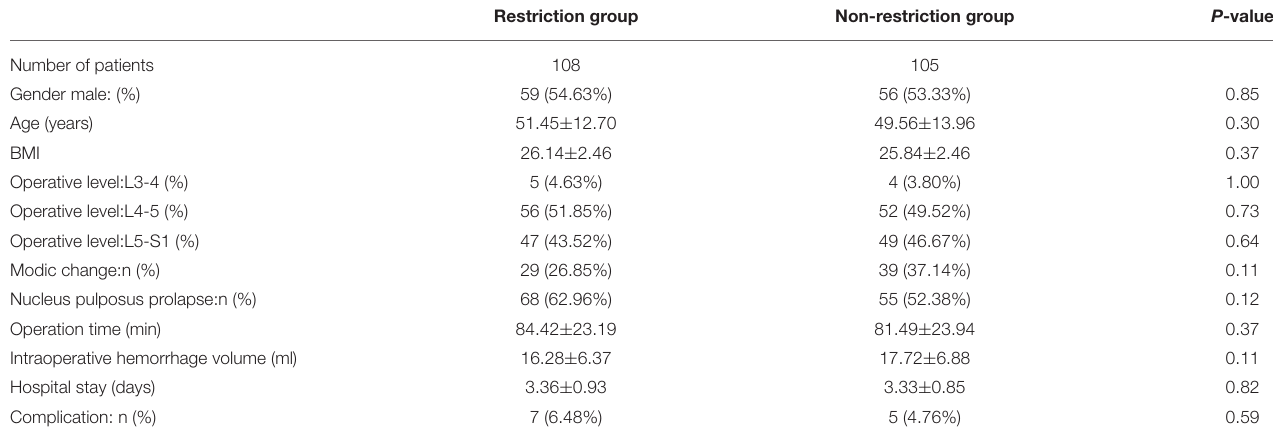
TABLE 1 | Demographic characteristics.